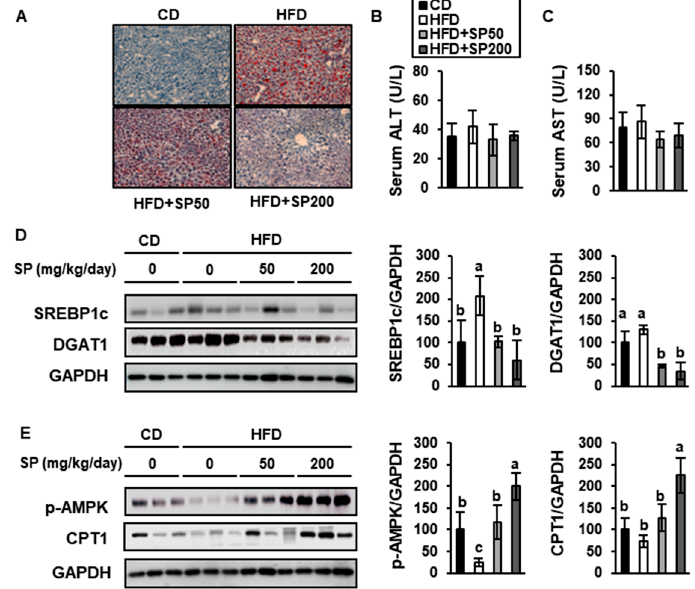
Figure 8. Silk peptide ameliorates hepatic steatosis and induces fatty acid oxidation in HFD-fed mice. ( A ) Representative images of Oil red O staining of liver sections from mice treated for 6 weeks. ( B ) Serum ALT and ( C ) AST were measured using colorimetric kits. The expression levels of proteins involved in ( D ) lipogenesis and ( E ) fatty acid oxidation. Data are expressed as mean ± SD ( n = 8). Values with di ff erent letters were significantly di ff erent; p < 0.05 (a > b >